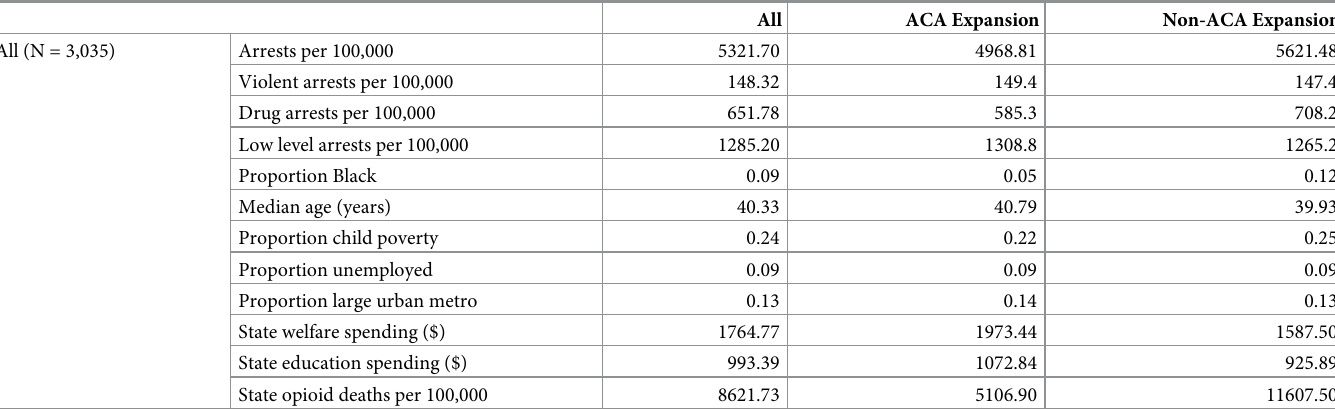
Table 2. Descriptive statistics for variables used in regression analysis of arrests by Medicaid expansion under the Affordable Care Act,